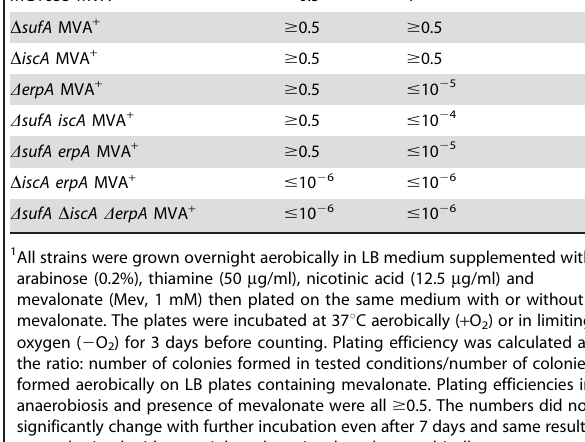
Number of clones on selective plates